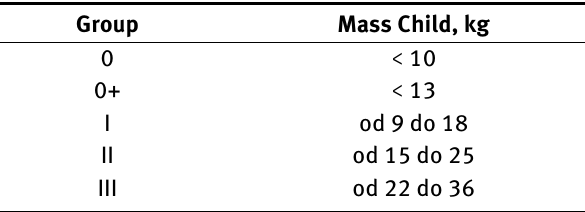
Table 1: Classification of vehicle seats according to Regulation